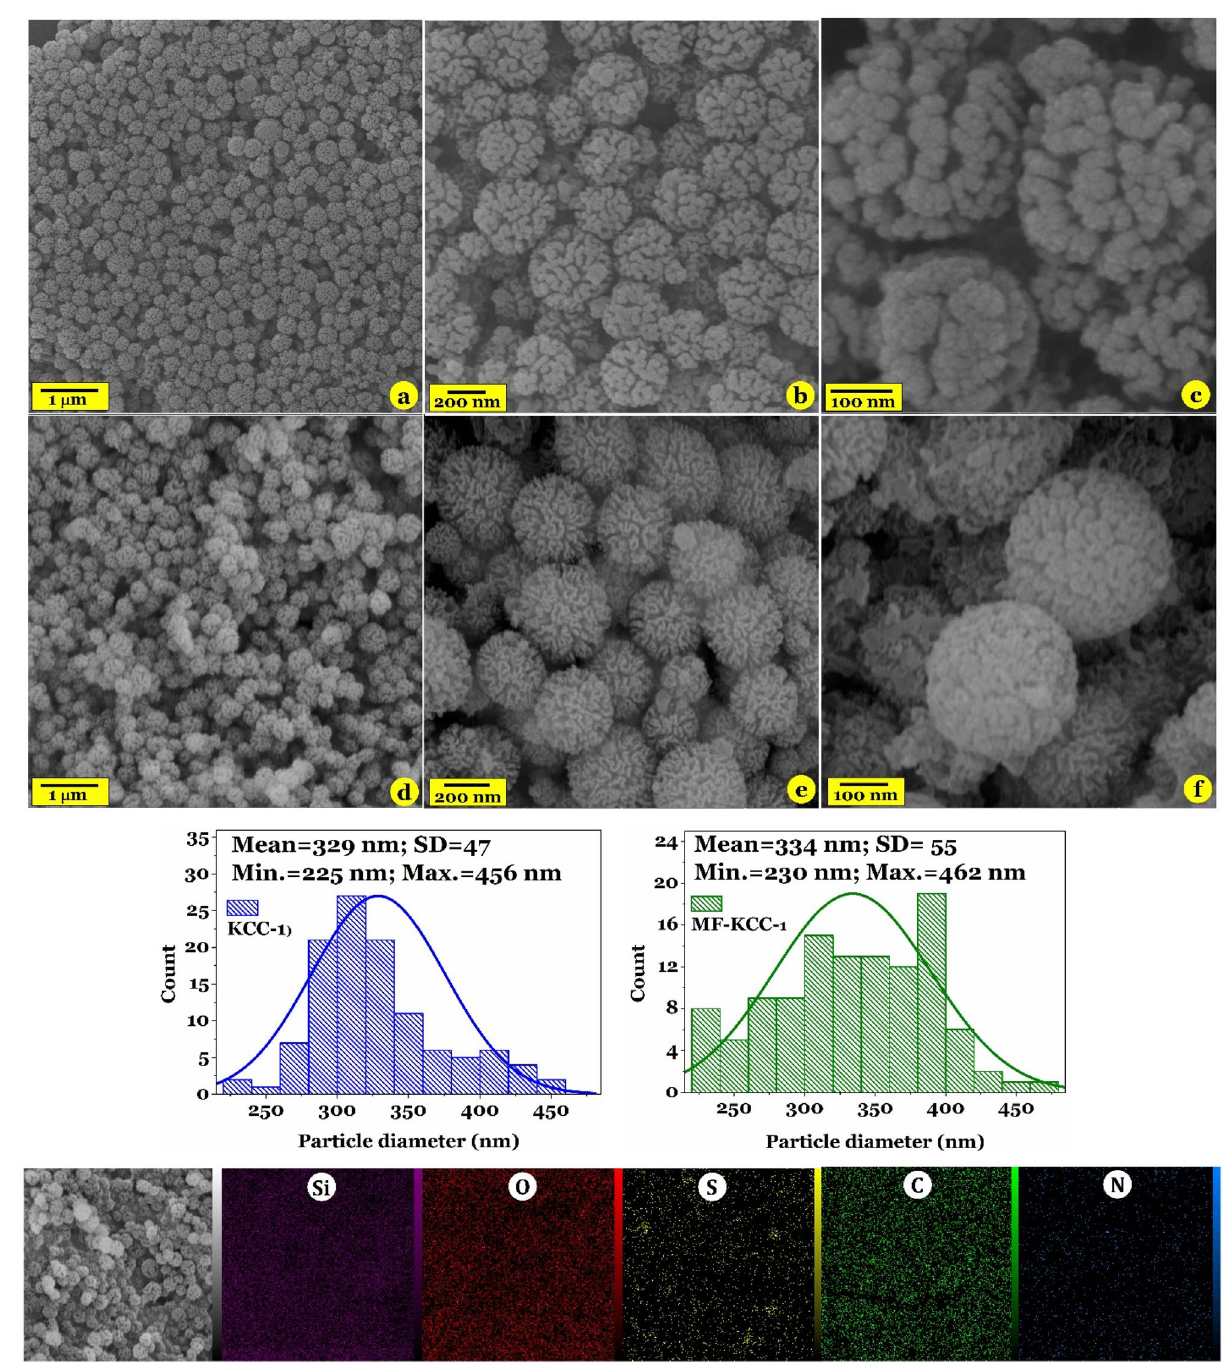
Figure 4. FESEM images of pure KCC-1 ( a – c ) and MF-KCC-1 ( d – f ) and corresponding particle size histogram (the third row). The fourth row indicates EDX dot elemental mapping images of the